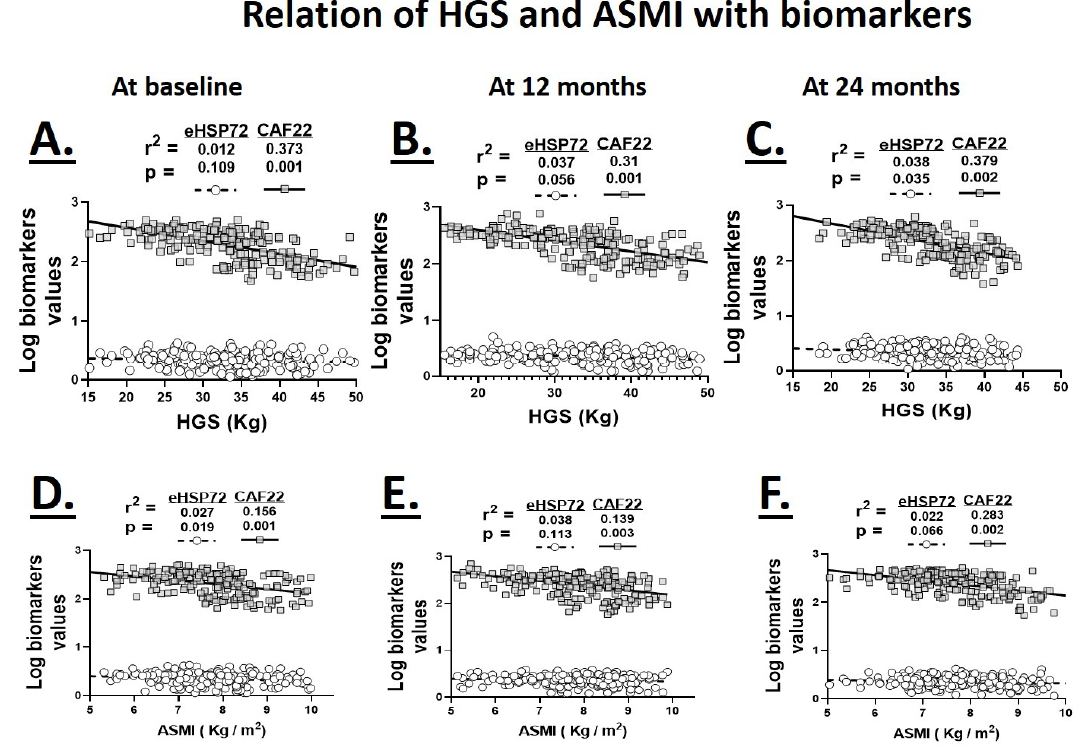
Figure 2. Relationship of serum levels of eHSP72 and CAF22 with hand-grip strength (HGS; A – C ) and